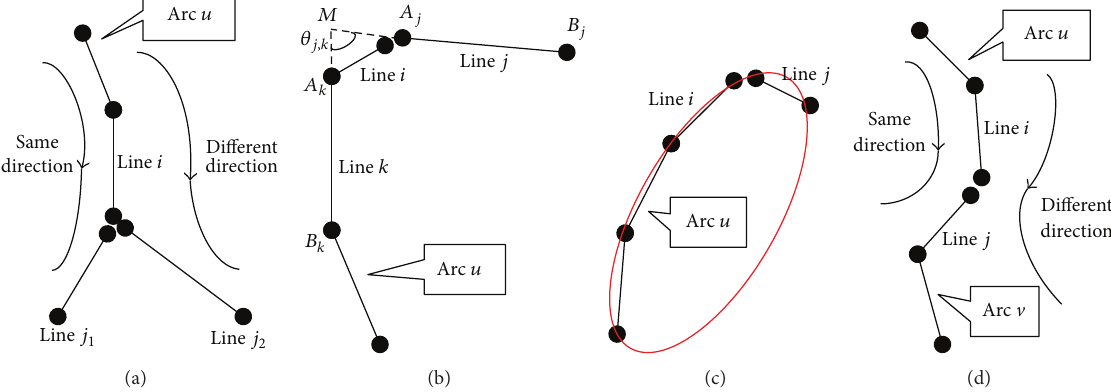
Figure 5: Illustrations of line segment merging conditions, where linked line segments denote elliptical arcs. (a) Rotating direction condition; line 𝑗 1 and arc 𝑢 are of the same rotating direction, satisfying the condition, while line 𝑗 2 and arc 𝑢 do not. (b) The length and angle condition; line 𝑗 and line 𝑗 generate a shape angle, not satisfying the condition. (c) The fitting condition; the fitting score of line 𝑗 is too low, not satisfying the condition. (d) The rotating direction condition for arcs; line 𝑗 and arc 𝑢 are of the same rotating direction, but line 𝑖 and arc V are not, preventing the two arcs from